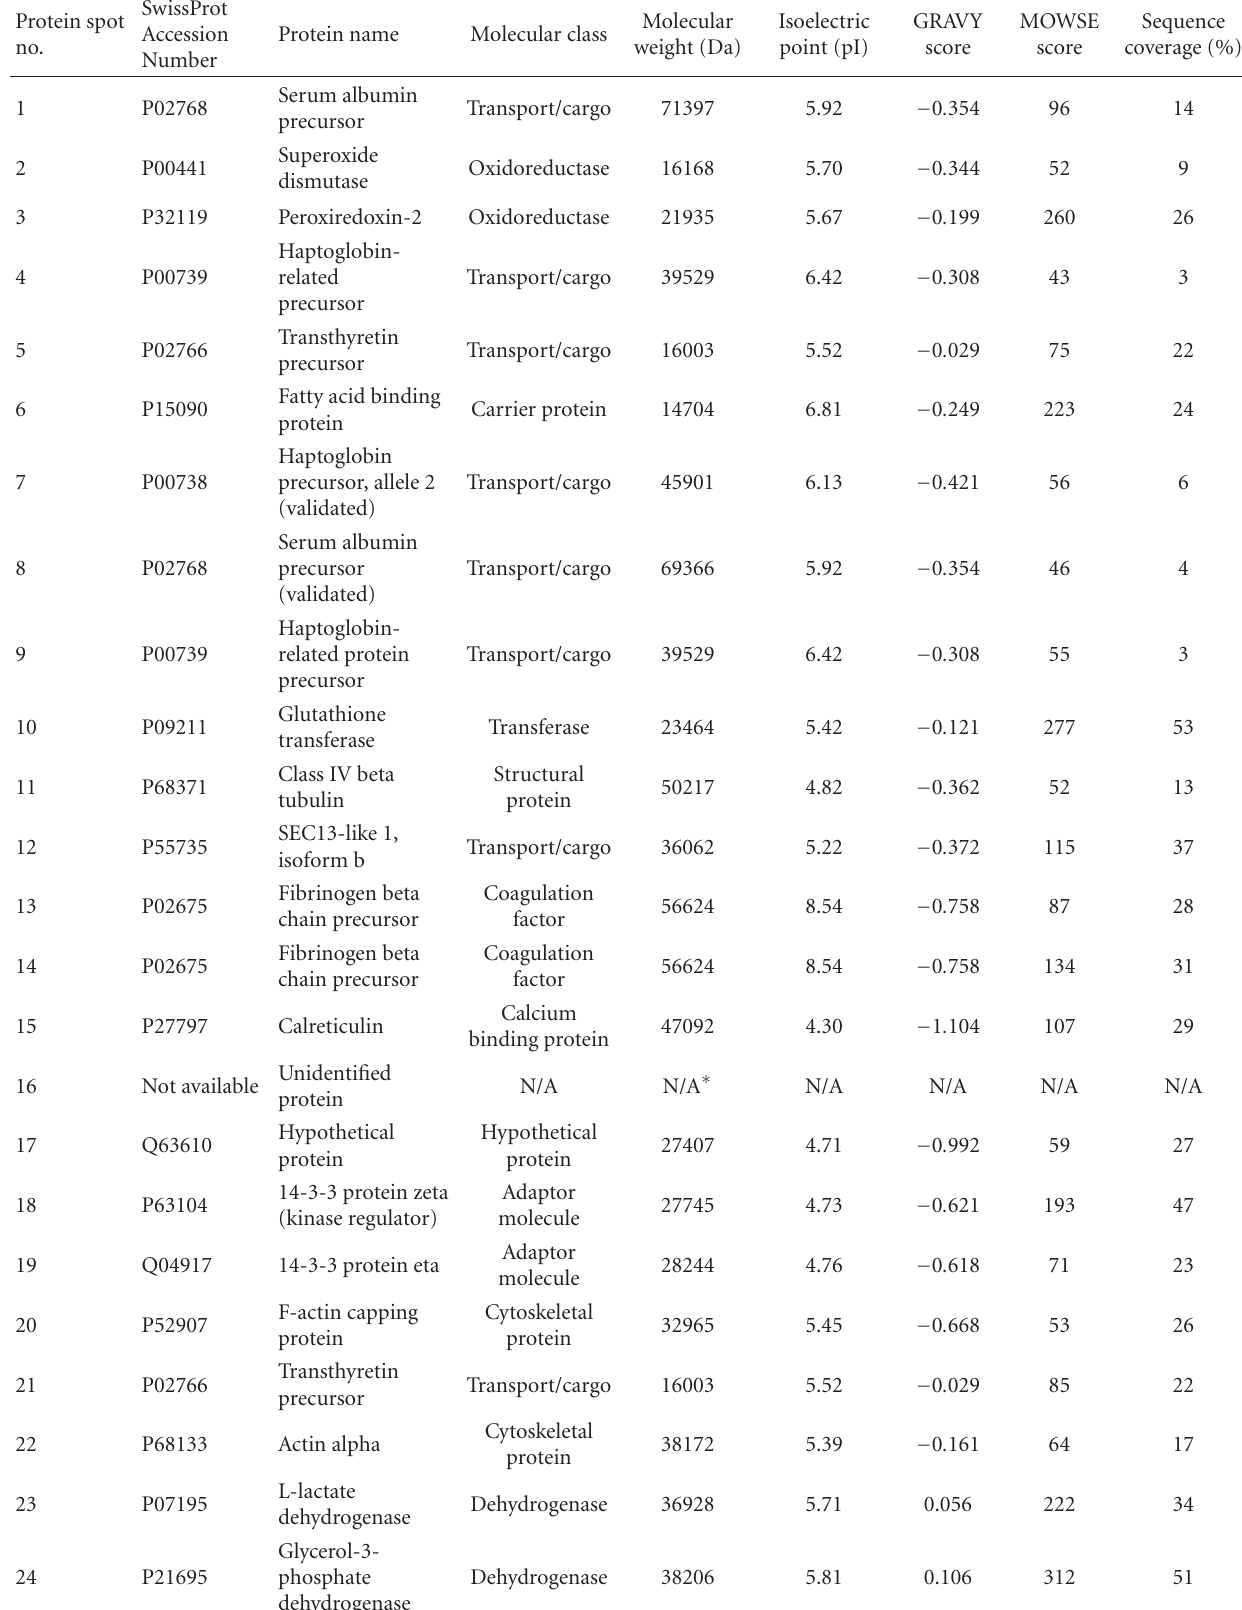
Table 2: Identity and properties of twenty-four di ff erentially expressed proteins. Protein